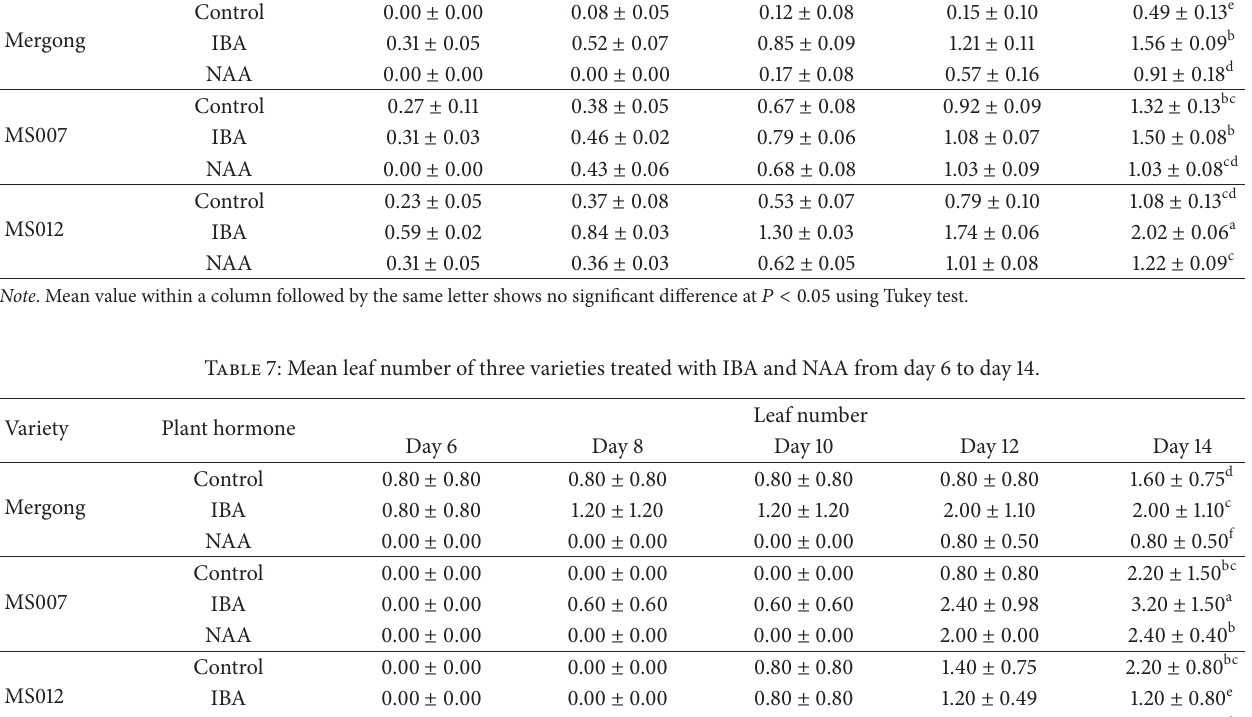
Table 6: Mean root length of three varieties treated with IBA and NAA from day 6 to day 14. Variety